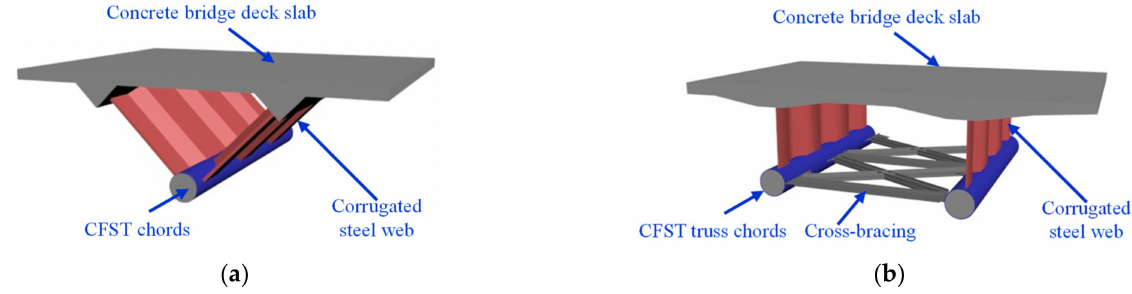
Figure 1. Composite girders: ( a ) CSW-CFST chords; and ( b ) CSW-CFST truss chords.